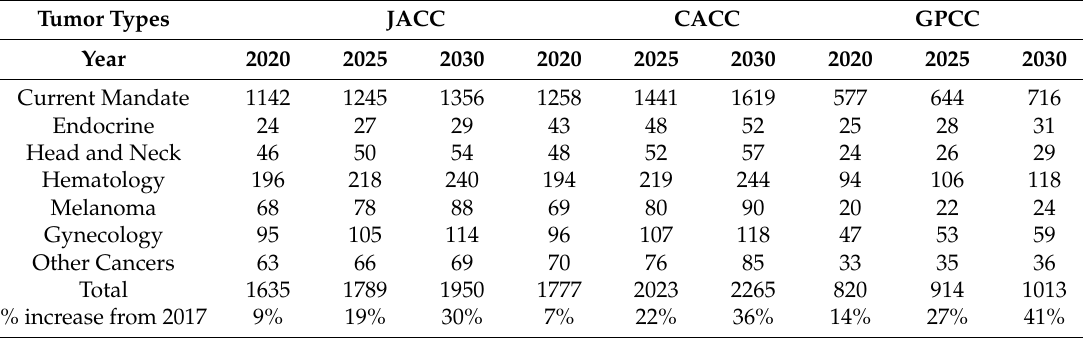
Table 3. 10-year growth projection for new cancer cases in Alberta’s three regional